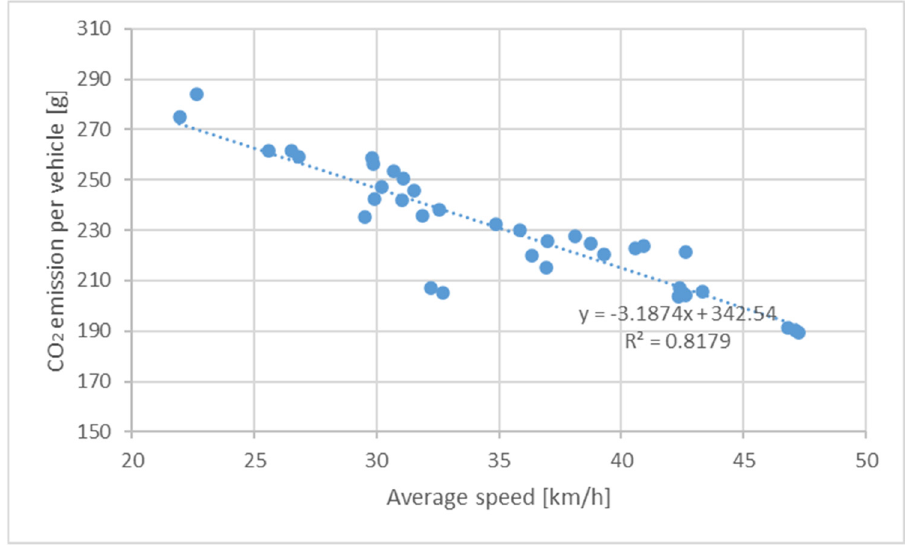
Figure 9. Relationship between CO 2 emissions and average speed in the simulation area.